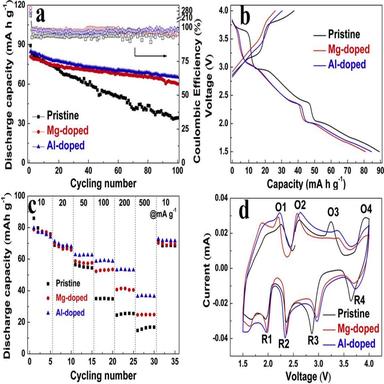
The electrochemical performances for the pristine, Mg-doped, and Al-doped cathodes. (a) Cycling performance at the rate of 20 mA g 1 . (b) The corresponding galvanostatic charge/discharge curves during the first cycle. (c) Rate capabilities at different rates from 10 mA g 1 to 200 mA g 1 . (d) CV curves at the scanning rate of 0.1 mV s 1 .